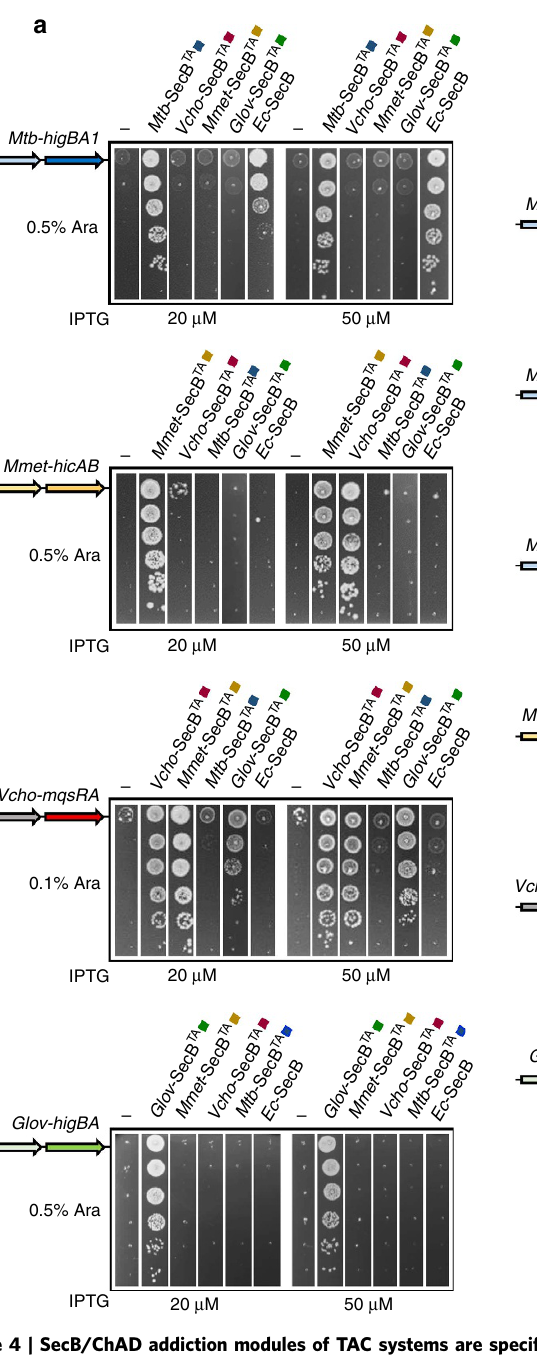
Figure 4 | SecB/ChAD addiction modules of TAC systems are specific. ( a ) Mtb -SecB TA , VchoA -SecB TA , Mmet -SecB TA and Glov -SecB TA chaperone specificity towards their cognate TA pair. Strain W3110 D secB was co-transformed with plasmid pK6- Mtb- HigBA1, pK6- VchoA -MqsRA, pK6- Mmet -HicAB or pK6- Glov -HigBA and pSE-based plasmids harbouring different SecB-like chaperones as indicated. Double transformants were grown to mid-log phase, serially diluted and spotted on LB–ampicillin–kanamycin agar plates containing arabinose and IPTG inducers as indicated. Plates were incubated at 37 (cid:2) C overnight. ( b ) Functional inter-species transfer of SecB/ChAD-specific pairs within TAC systems using antitoxin chimeras. Strain W3110 D secB was co-transformed with pK6-based plasmids containing chimeric TA systems in which the putative ChAD regions have been swapped, and pSE derivatives harbouring different SecB-like chaperones as indicated, and analysed by spot tests as in a